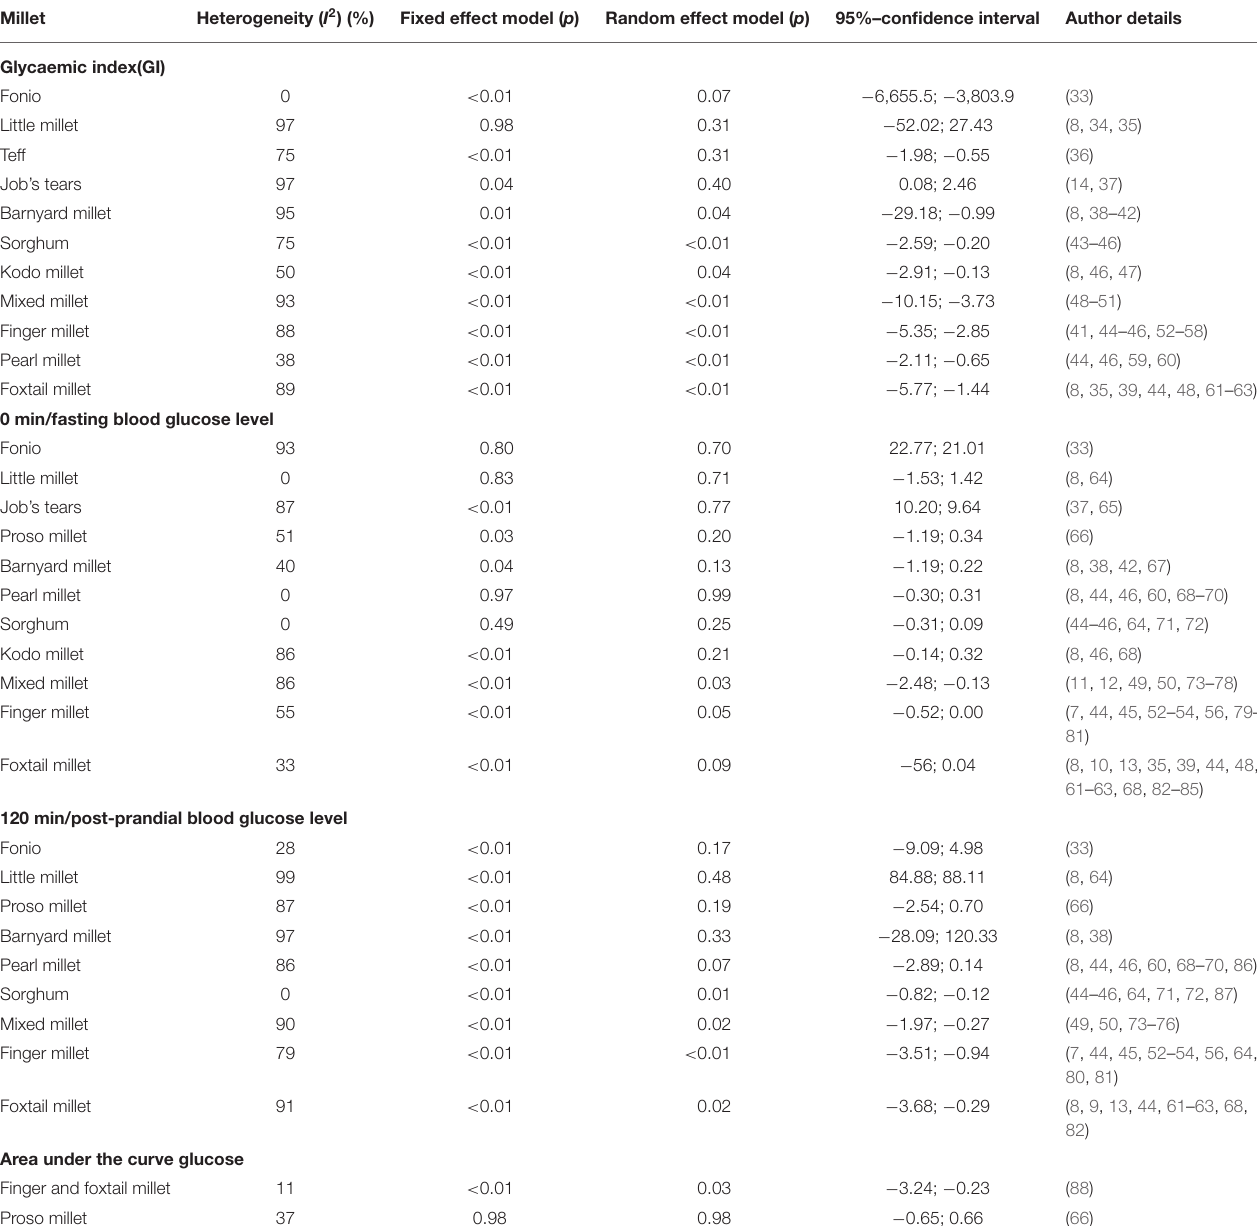
TABLE 3 | Heterogeneity and p values from fixed and random effect models from forest plots on glycaemic index, fasting and post-prandial blood glucose levels.